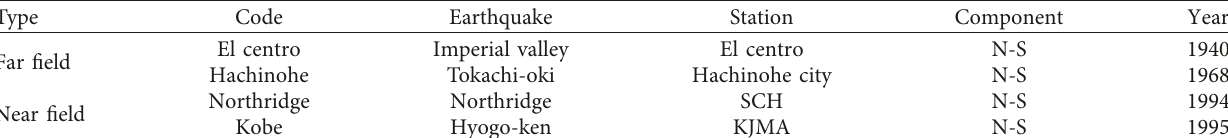
Table 3: Information about earthquake records.